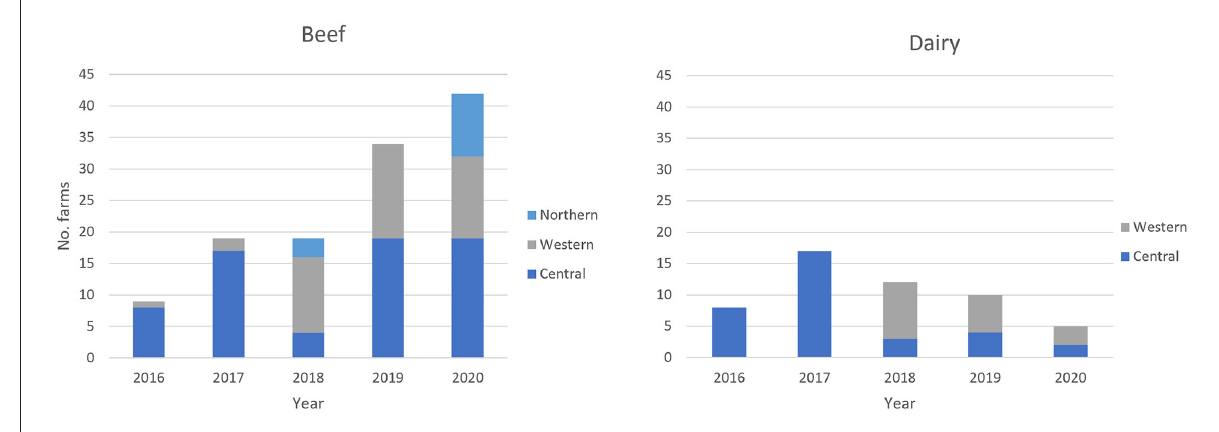
FIGURE4 Geographic location of the bTB positive newly enrolled beef and dairy farms from 2016 to 2020.